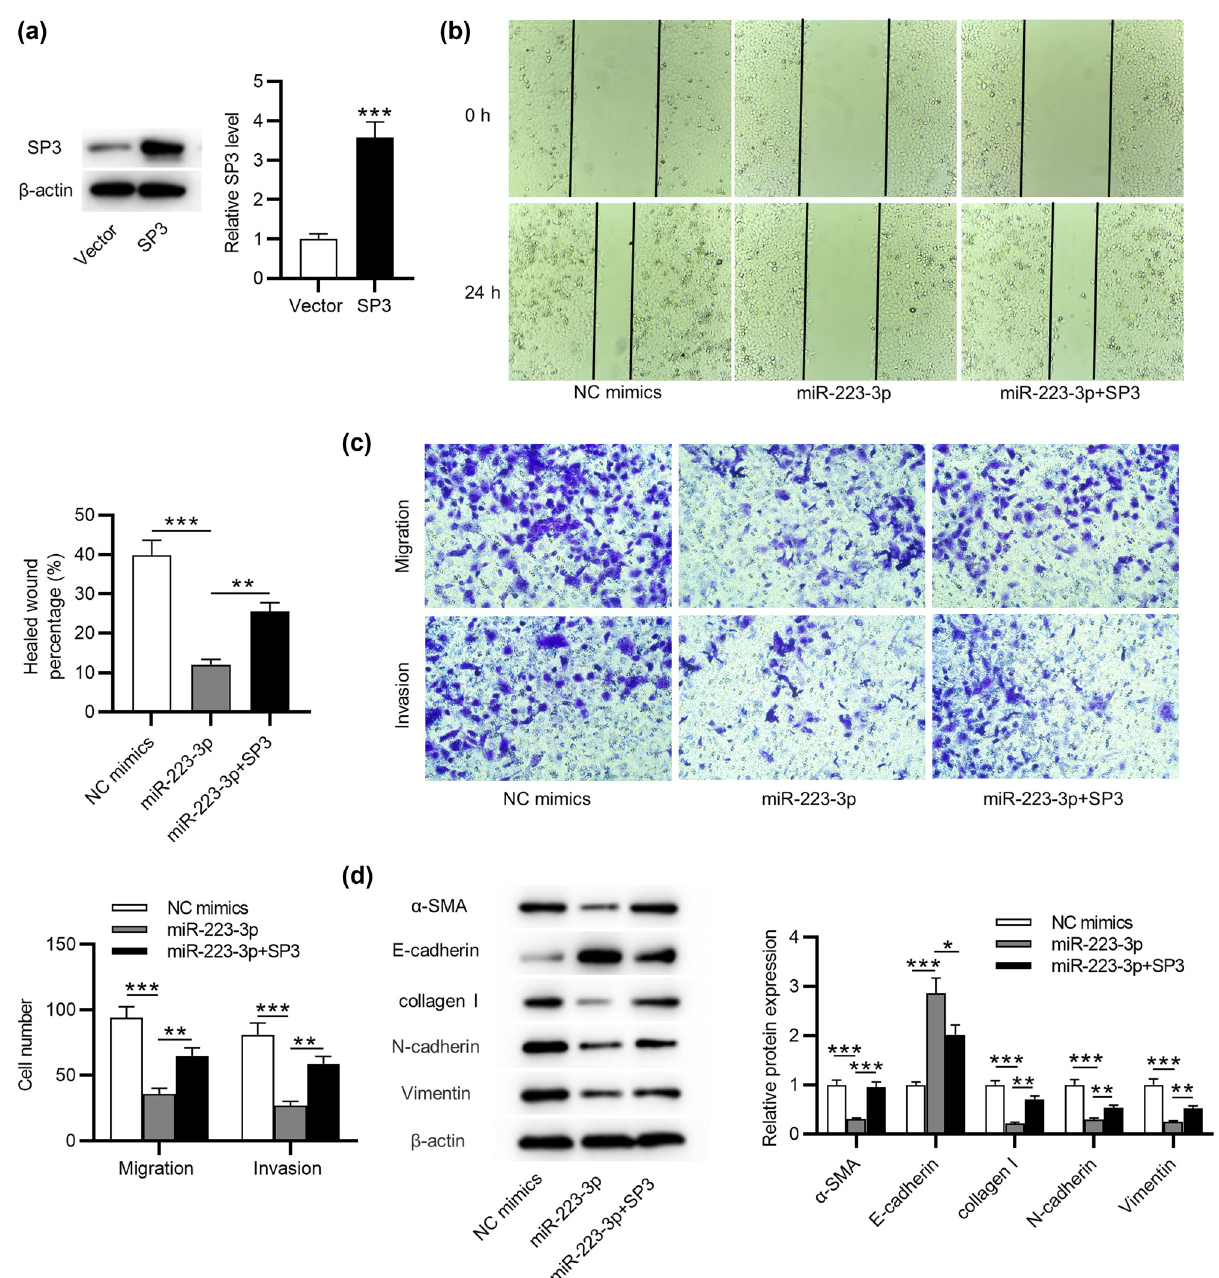
Figure 4: SP3 counteracts the in fl uence of miR - 223 - 3p. ( a ) Western blotting for analyzing pcDNA3.1/SP3 transfection e ffi ciency. ( b ) Wound healing assay for evaluating cell migration after transfection of miR - 223 - 3p mimics, miR - 223 - 3p mimics + pcDNA3.1/SP3 or NC mimics. ( c ) Transwell assay for assessing the migration and invasion of EECs with above transfection. ( d ) Protein levels of EMT and ECM markers by western blotting in cells with above transfection. All experiments were performed in triplicate and data are presented as the mean value ± SD. Student ’ s t - tests were performed for panel ( a ) , while ANOVA followed by Tukey ’ s post hoc analysis was performed for panels ( b – d ) . * p < 0.05, ** p < 0.01, miR - 223 - 3p + SP3 vs miR - 223 - 3p group; *** p < 0.001, SP3 vs vector group or miR - 223 - 3p vs NC mimics